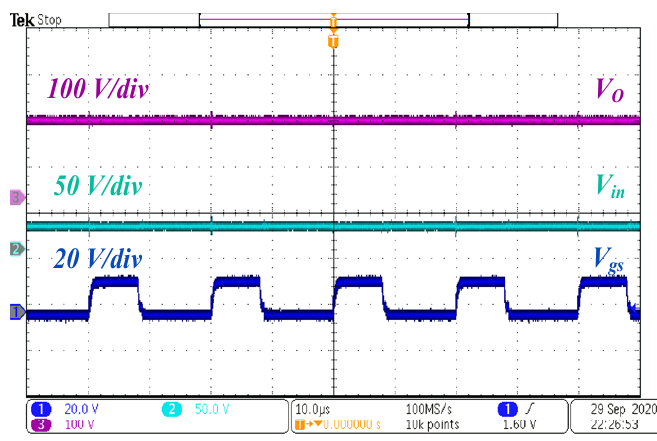
Figure 13. ( a ) Proposed converter; ( b ) experimental set-up.